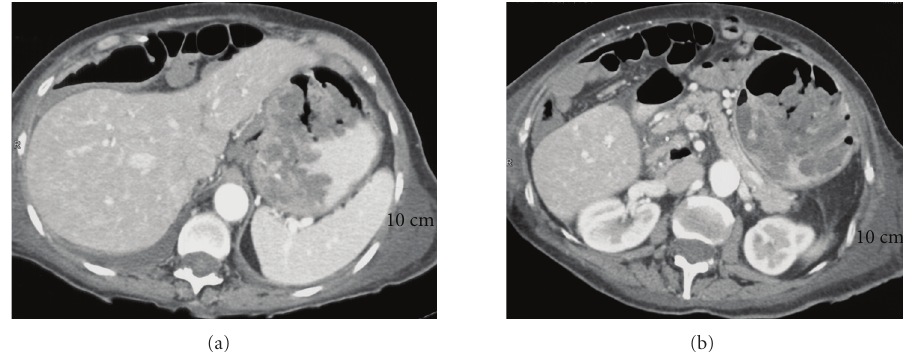
Figure 1: (a) Axial CT through the gastric cardia demonstrates large lobular folds forming a mass-like configuration. (b) Axial CT through the gastric body shows a distended stomach with multiple lobular mass-like folds.